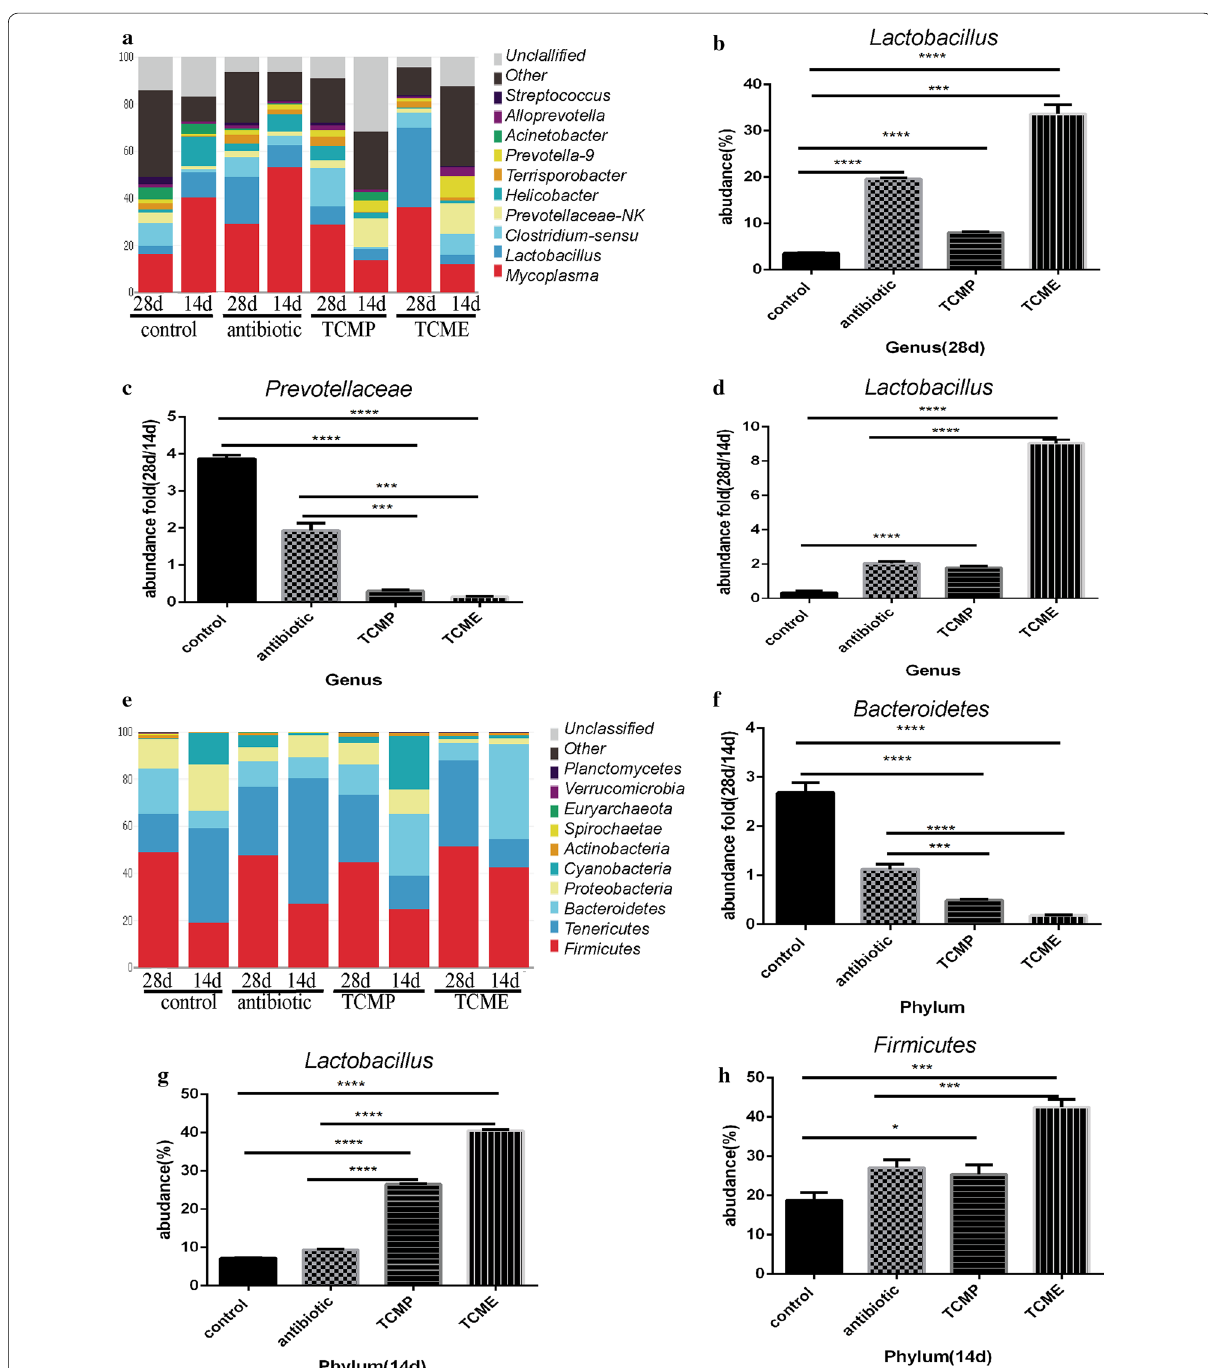
Fig. 7 Effect of coix seed on the composition of jejunal microbiota with respect to genus and phylum. a Effect of coix seed on the composition of jejunal microbiota with respect to genus in weaned pigs. b Abundance of genus Lactobacillus. c Fold abundance of genus Prevotellaceae (28D/14D). d Fold abundance of genus Lactobacillus (28D/14D). e Effect of coix seed on the composition of jejunal microbiota with respect to phylum in weaned pigs. f Fold abundance of phylum Bacteroidetes (28D/14D). g Abundance of phylum Lactobacillus . h Fold abundance of phylum Firmicutes (14D). (* p < 0.05; ** p < 0.02; *** p < 0.01, **** p <